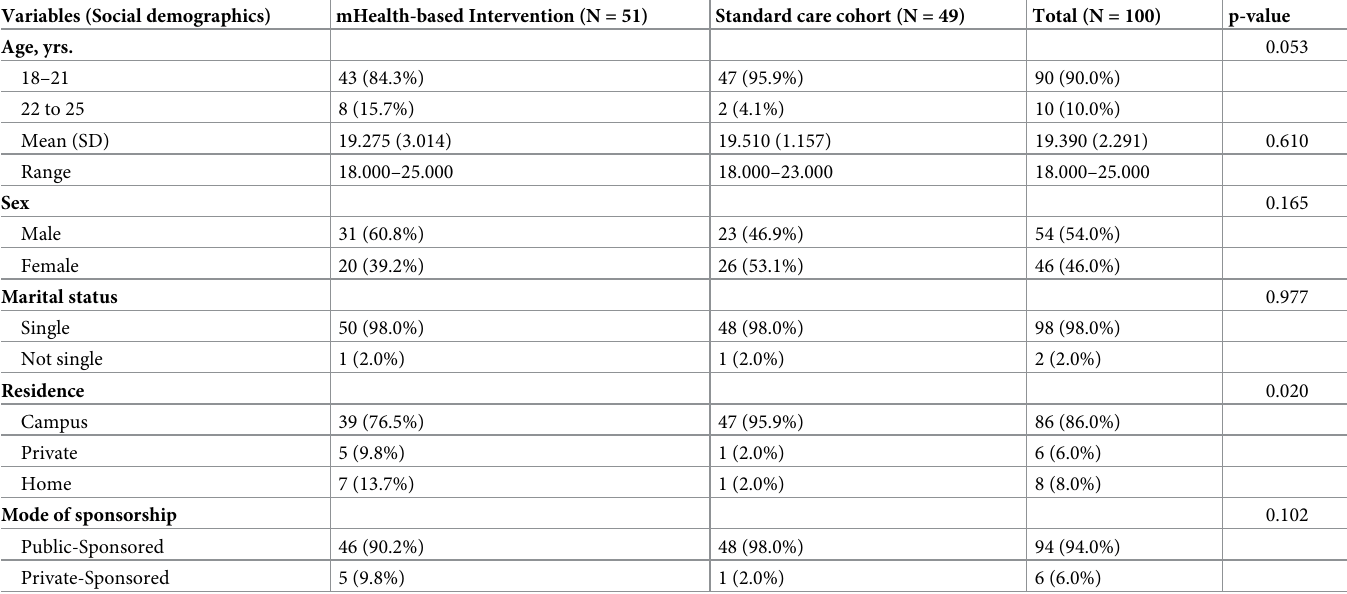
Table 1. Social Demographic characteristics of Peer